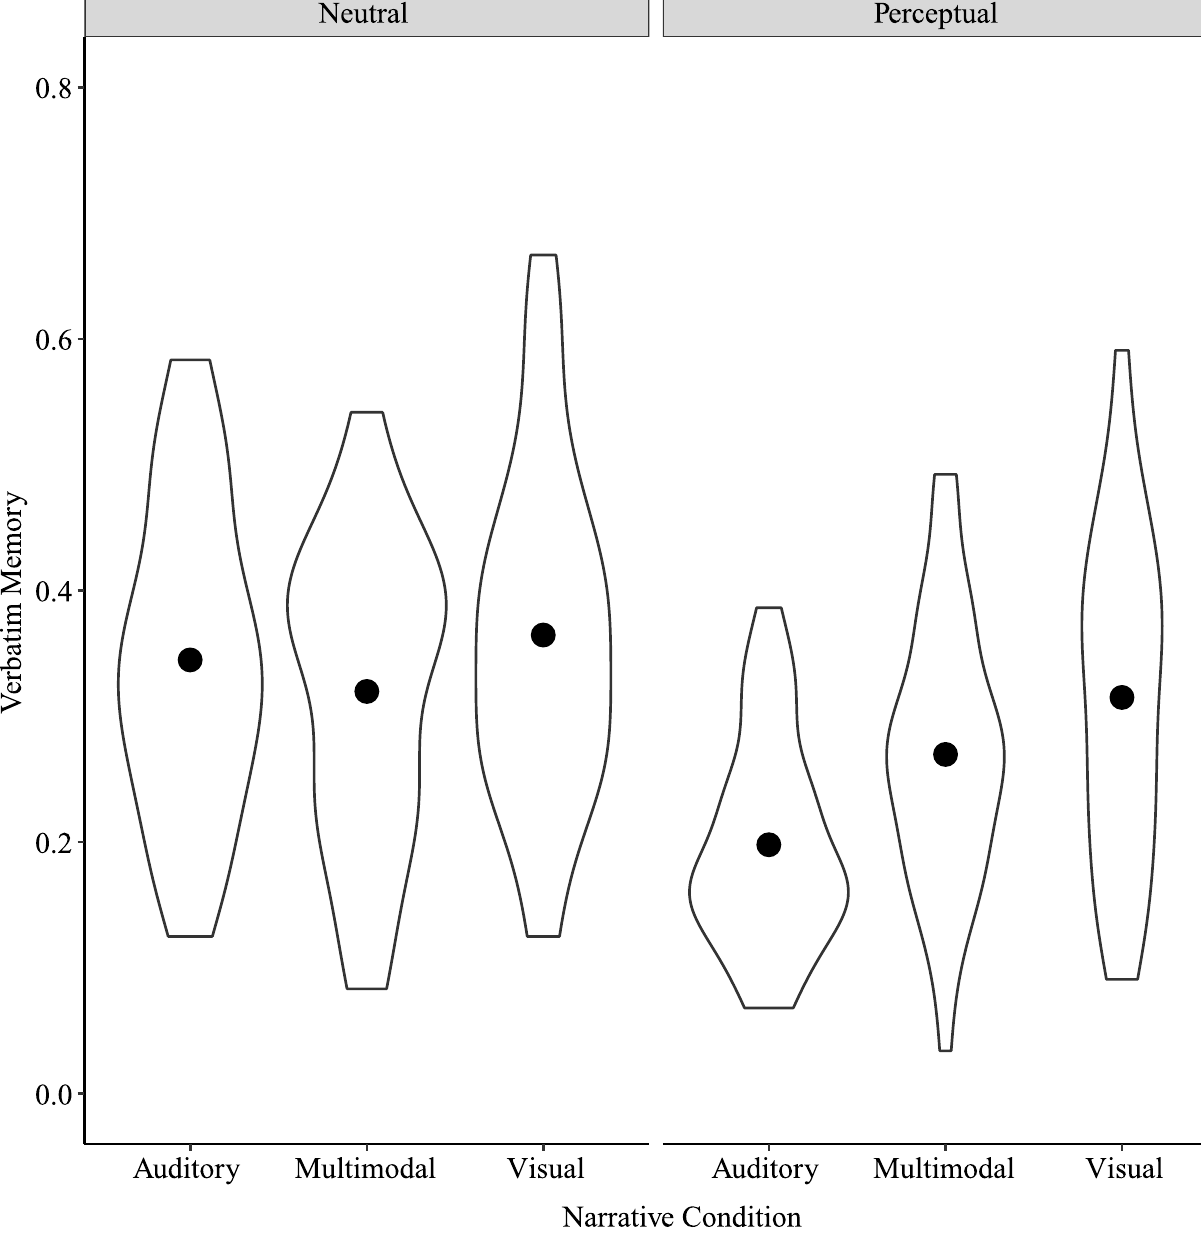
Fig 3. Verbatim memory by Narrative Condition and Detail Type for Study 1. Points show means for each Narrative Condition by Detail Type.